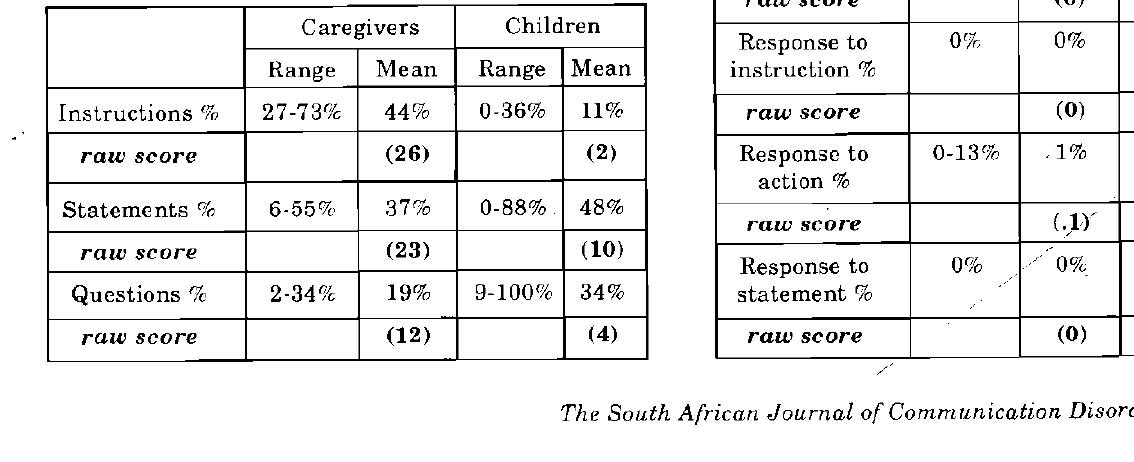
Table 6. Function of subjects' utterances